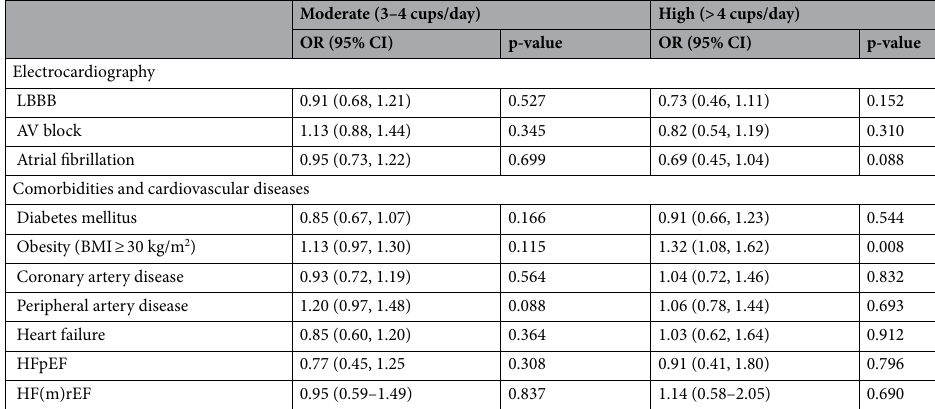
Table 3. Logistic regression analysis of electrocardiographic findings, comorbidities, and cardiovascular diseases with moderate and high coffee consumption. Mild coffee consumption (< 3 cups/day) served as a reference. Adjustment was performed for age, sex, BMI, diabetes, arterial hypertension, smoking, and additives. AF atrial fibrillation, LBBB left bundle branch block, RBBB right bundle branch block, AV block atrioventricular block, HFpEF heart failure with preserved ejection fraction, HF(m)rEF heart failure with (mildly) reduced ejection